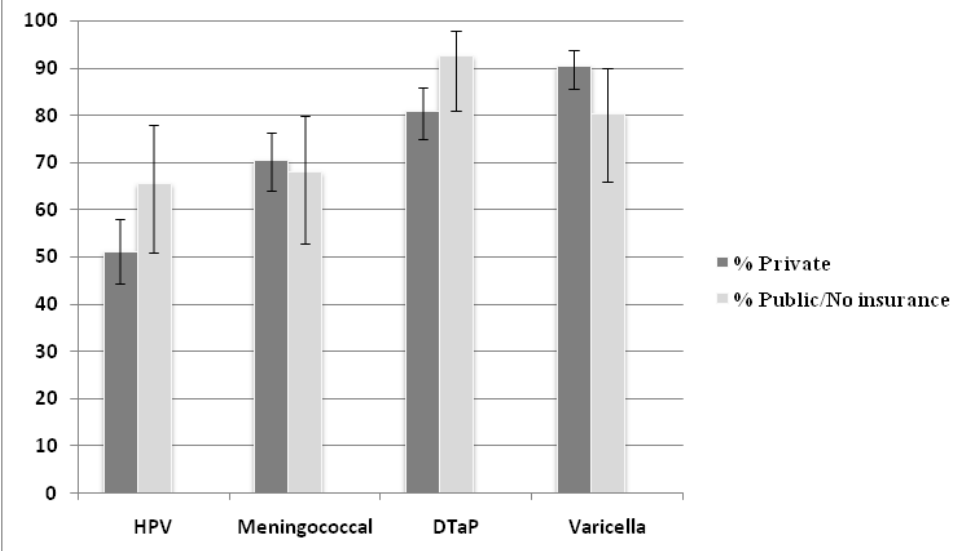
Figure 3. Vaccination rates of recommended adolescent vaccines by insurance status.